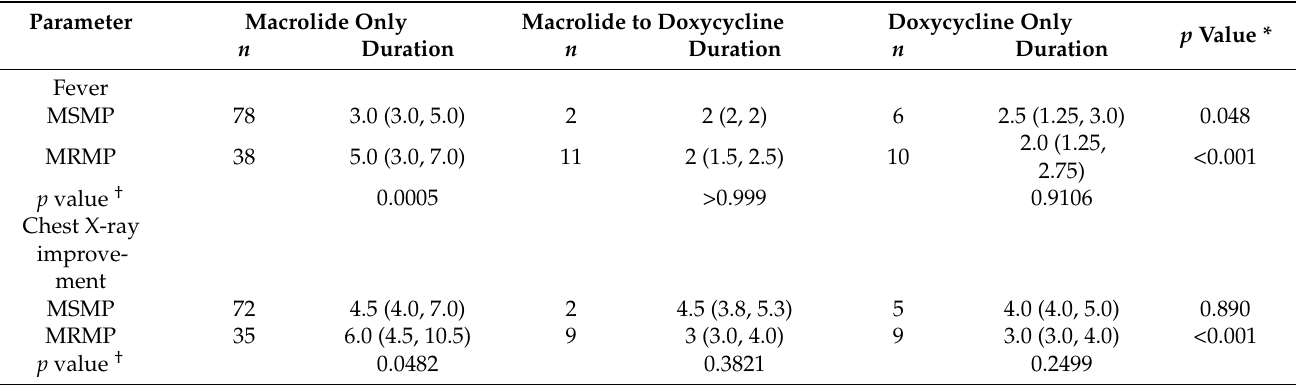
Table 3. Clinical response according to antibiotic treatment in children with Mycoplasma pneumoniae pneumonia related to macrolide